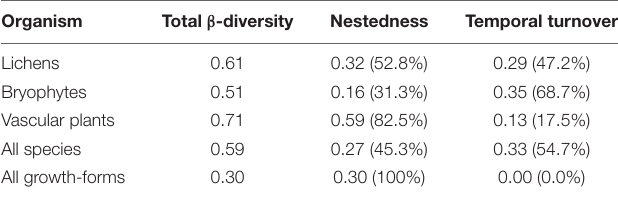
TABLE 2 | Analysis of multi-site β -diversity for lichens, bryophytes and vascular plants and for the whole vegetation analyzing all species of photosynthetic organisms